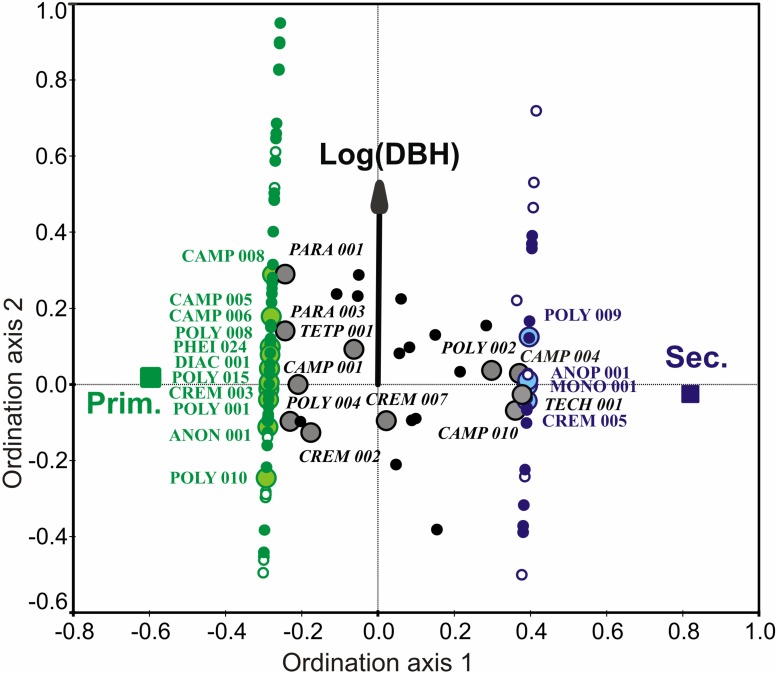
Ordination diagram of ant species composition in studied trees.Ordination based on CCA analysis (see Table 3 for the significance and % of variance related to the ordination canonical axes). Variation of ant community composition (all presence—absence records of ant species in trees) is related to the explanatory variables Forest plot on the first axis (primary and secondary rainforest) and Tree size on the second axis (DBH after logarithmic transformation). Solid symbols indicate tree-nesting species and empty symbols the species found only foraging in trees (in green: occurrence of the species in primary forest, in blue: secondary forest, in black: both forests). The enlarged symbols with species abbreviations refer to the most common ant species (i.e. present in > 20 trees, see S1 Table for their full names).